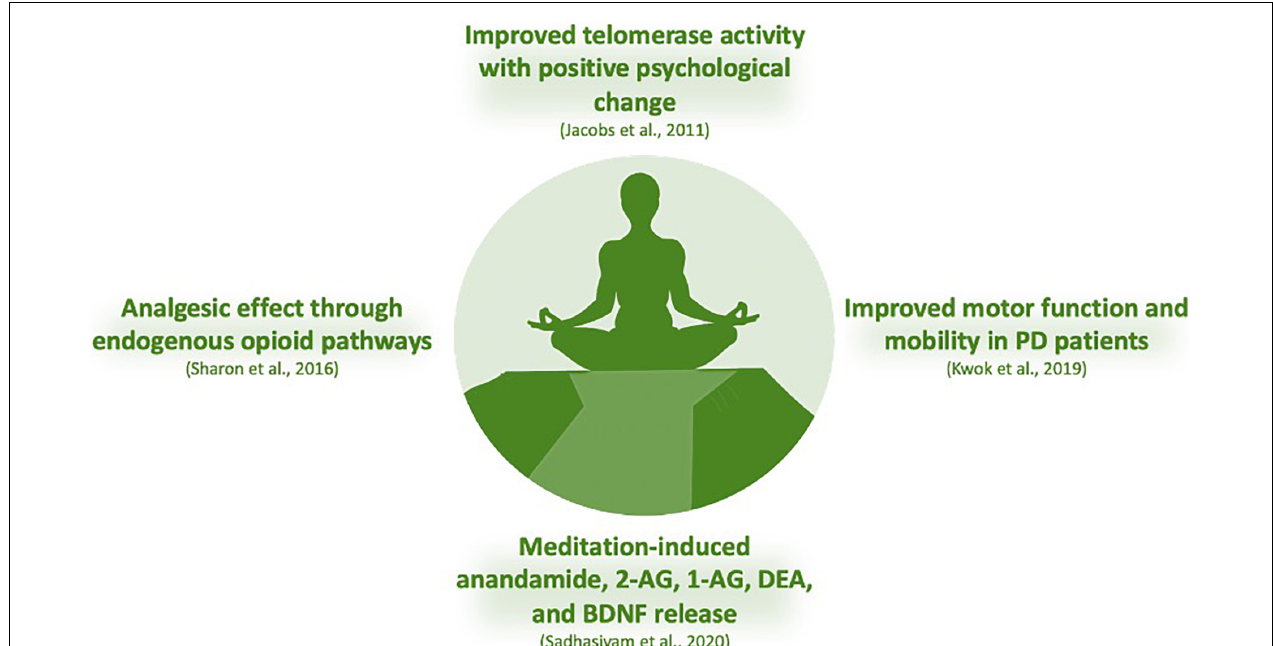
FIGURE 5 | Regular mindfulness practice has consequences on physiological and psychological functioning with performance outcomes in sports, improving sleep quality and work stress. Data on regular yoga users (transcendental meditation) faced modest average reductions in blood pressure. Depression or anxiety have